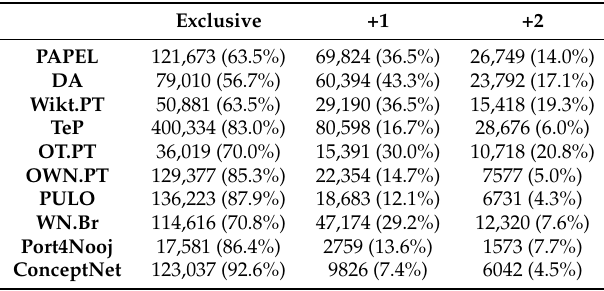
Table 5. Proportion of relation instances in each LKB that occur only in this LKB, this and another, and this and two other LKBs.